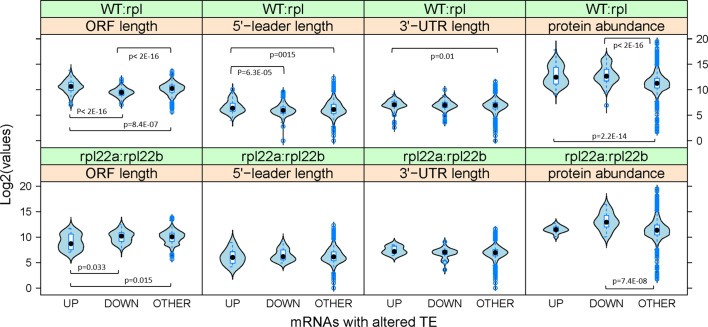
Features of mRNAs with altered translational efficiency in rpl mutants.Top, All the mRNAs shown in Figure 5—figure supplement 3 that had altered translational efficiency between wild type and any of the rpl deletion strains were placed in the following groups: UP, if their median of their log2[(ribo/rna)WT/(ribo/rna) rplΔ] values from all cell cycle points was positive; DOWN, if their median of their log2[(ribo/rna)WT/(rio/rna)rplΔ] values from all cell cycle points was negative; OTHER if they were not identified as being under translational control between wild type and any of the rpl deletion strains. The values for ORF, 5’-leader (5’-UTR), and 3’-UTR length for each of the mRNAs were from Lin and Li, 2012. The protein abundance values were the median number of molecules per cell, from the studies analyzed in Ho et al., 2018. The violin plots were generated with the lattice R language package. Significant differences in pair-wise comparisons were indicated by the non-parametric Kruskal-Wallis test, while the p-values shown were for all significant differences based on the posthoc Nemenyi test (performed with the PMCMR R language package). Bottom, The same analysis as in the top panels for the mRNAs with different translational efficiency between the rpl22aΔ and rpl22bΔ mutants, based on their log2[(ribo/rna)rpl22aΔ/(ribo/rna)rpl22bΔ] values.